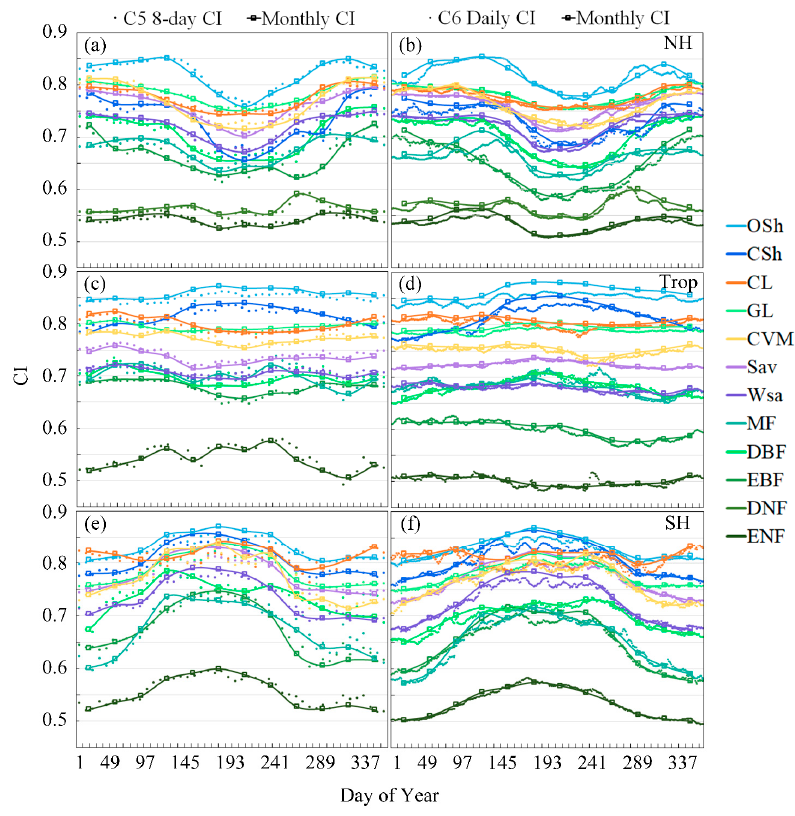
Figure 5. Seasonal variations in the MODIS C5 ( a , c , e ) and C6 ( b , d , f ) CIs averaged over the Northern Hemisphere (NH, 30–90°N), Southern Hemisphere (SH, 30–90°S), and tropics (Trop, 30°S–30°N) for different IGBP land cover types in 2015. The dots indicate variations in the C5 8-day CI and C6 daily CI, while the line with squares denotes variations in the monthly CI. ENF: evergreen needleleaf forests; DNF: deciduous needleleaf forests; EBF: evergreen broadleaf forests; DBF: deciduous broadleaf forests; MF: mixed forests; CSh: closed shrublands; OSh: open shrublands; WSa: woody savannas; Sav: savannas; GL: grasslands; CL: croplands; CVM: cropland/natural vegetation mosaics.